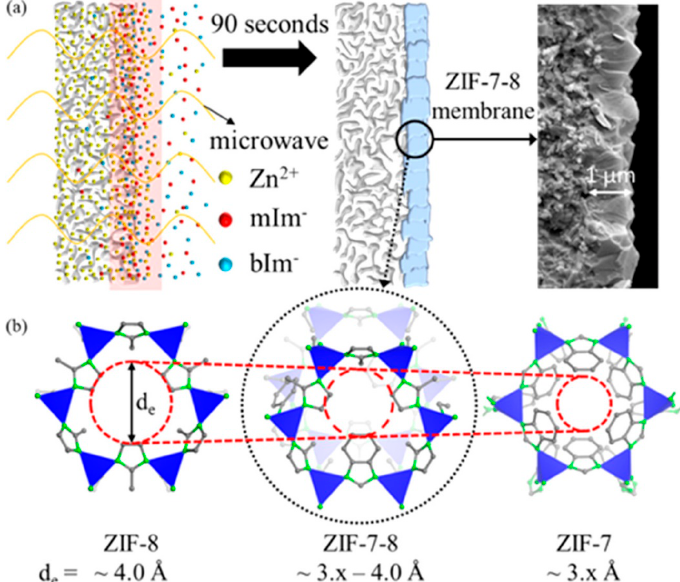
Figure 55. ( a ) Schematic illustration for the rapid microwave-assisted in situ synthesis of mixed linker ZIF-7-8 membranes and ( b ) comparison of effective pore aperture of ZIF-8, ZIF-7, and mixed linker ZIF-7-8. de = effective aperture size. (adapted with permission from ref. [66]).